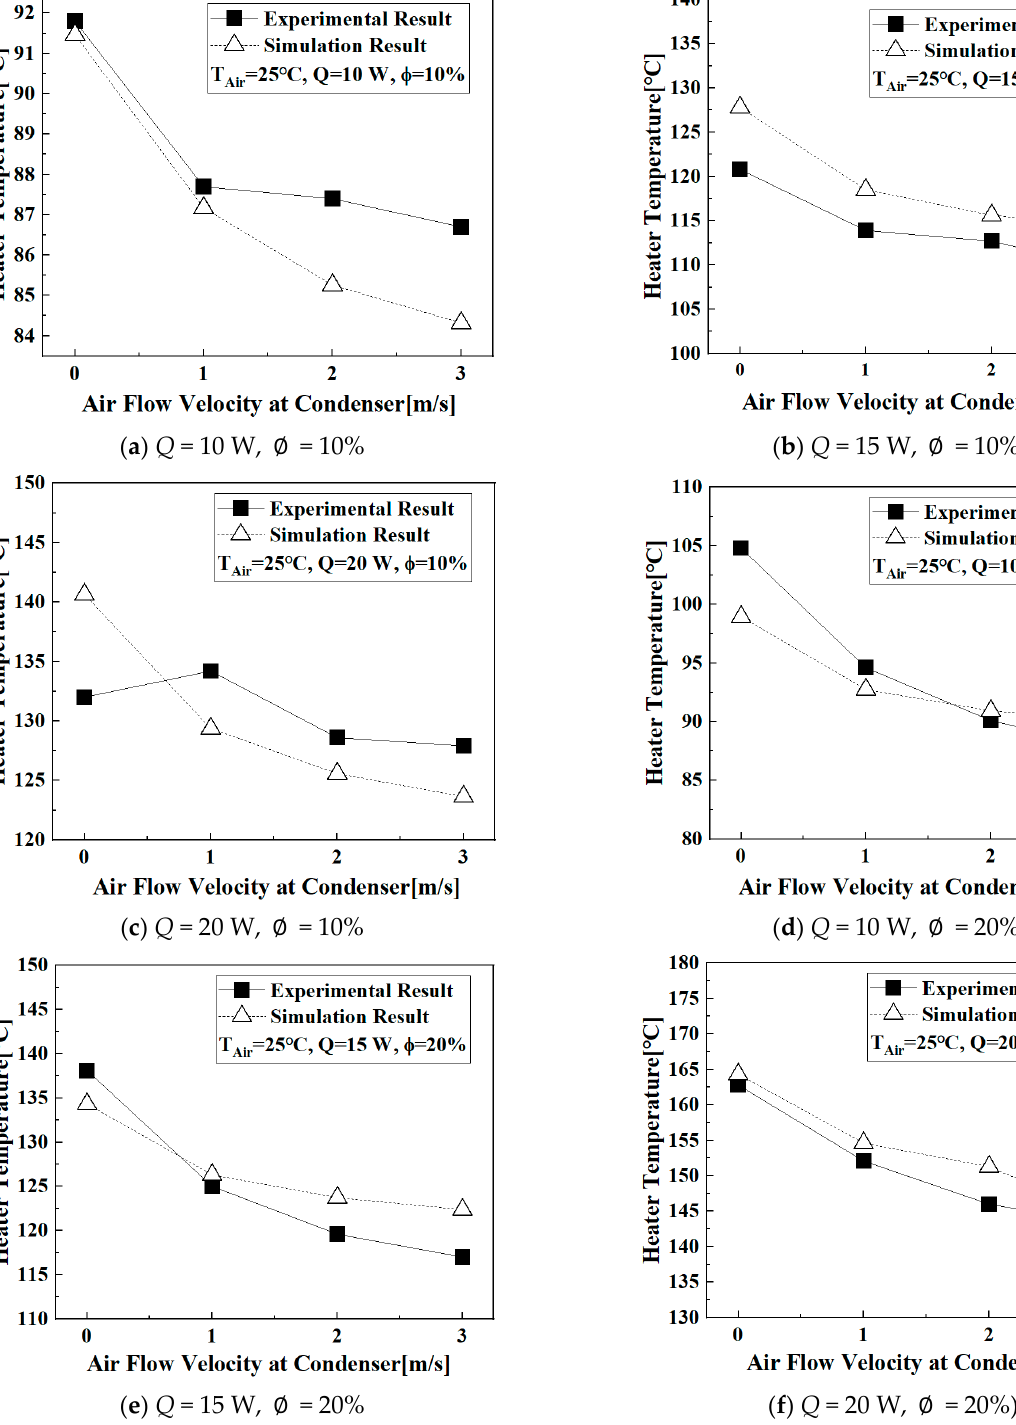
Figure 11. Comparison of experimental and simulation results regarding the effect of the airflow rate on the heater temperature according to ∅ , Q , and V air (pitch angle = 0°, and roll angle =